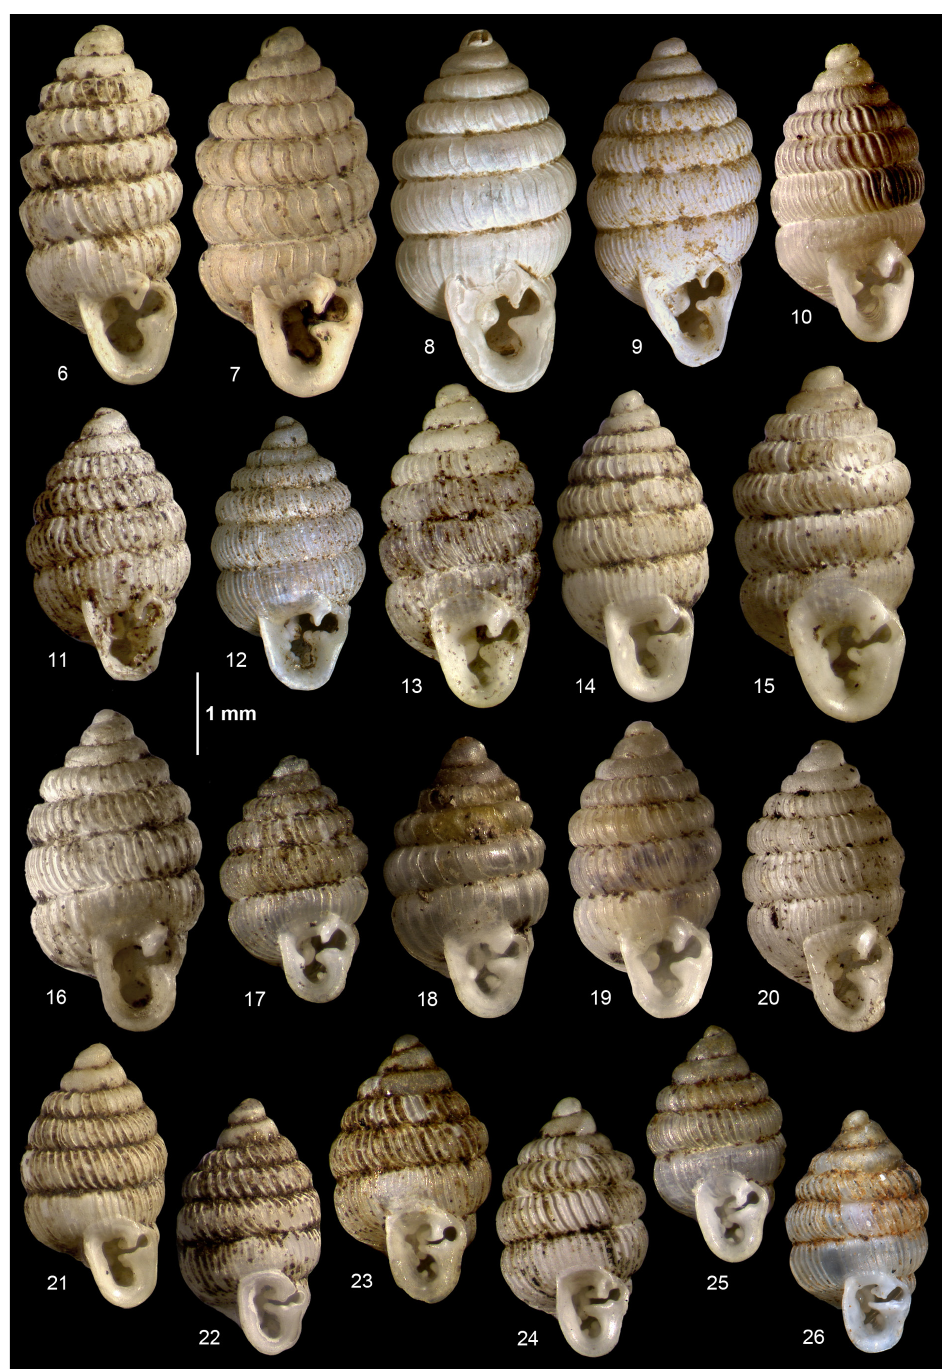
Figs 6-26. Adult shells of Dadagulella radius (Preston, 1910) comb. nov., D. browni (van Bruggen, 1969) comb. nov. and their respective subspecies. 6-20. D. radius comb. nov. s.l. 6-8. D. radius calva (Connolly, 1922): 6. Lectotype, Taru Desert. 7. Taru Desert near Malindi. 8. Near Mombasa. 9-20. D. radius radius : 11. Lectotype, Shimba Hills. 12. Gazi. 13. also Gazi. 14. Diani Beach. 15. Amboni. 16. Kimboza. 17. Mkungwe. 18. Pugu. 19. Mbudya I. 20. Jozani. 21-26. D. browni comb. nov. s.l. : 21. D. browni mafiensis subsp. nov., holotype, Mlula. 22. D. browni semulikiensis subsp. nov., holotype, Semuliki NP. 23-26. D. browni browni : 23. Mwanihana. 24. Mzelezi. 25. Pomene Bay. 26. Holotype, Lake Sibayi (after van Bruggen